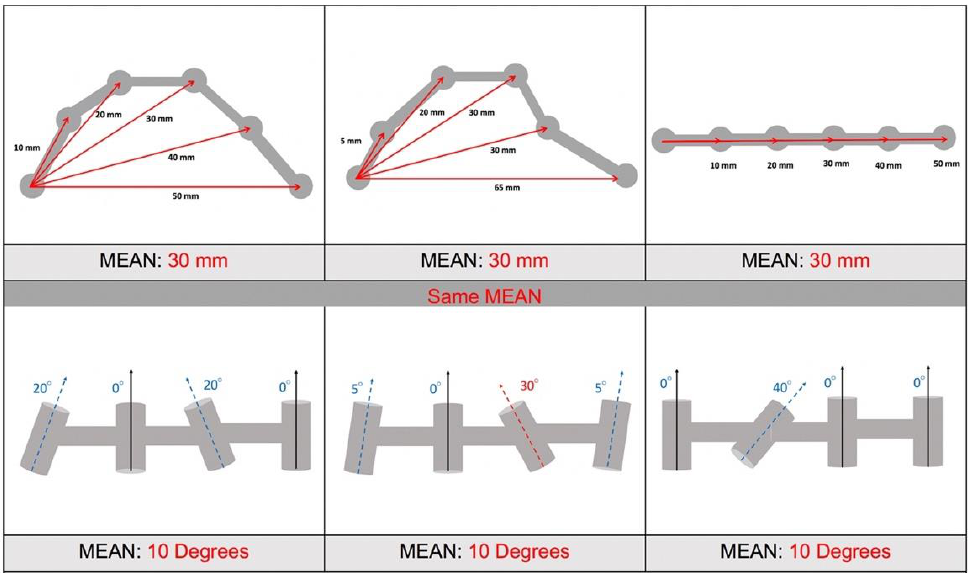
Figure 9. Analysis of trueness/precision calculated with each distance individually is more represen- tative of real distortions than the means. See in the image that the same mean error can mean very different level of individual deviations, with very different clinical implications.